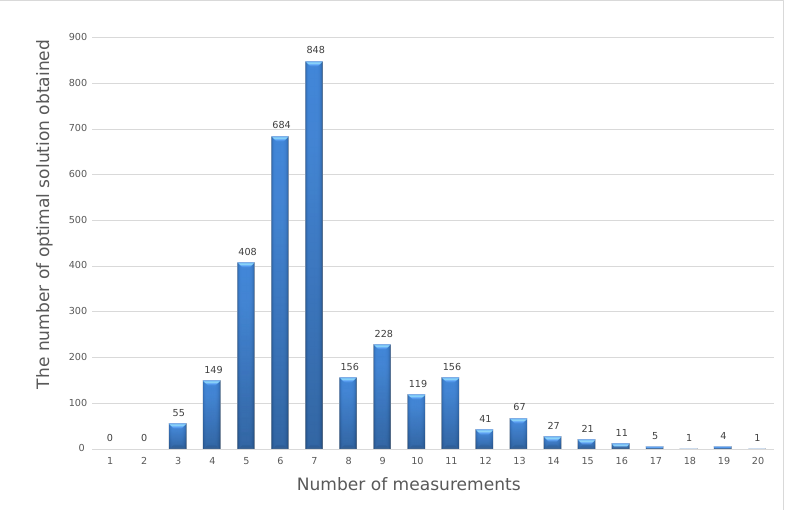
Figure 8. The result of optimization calculations with three methods for the point 40 V